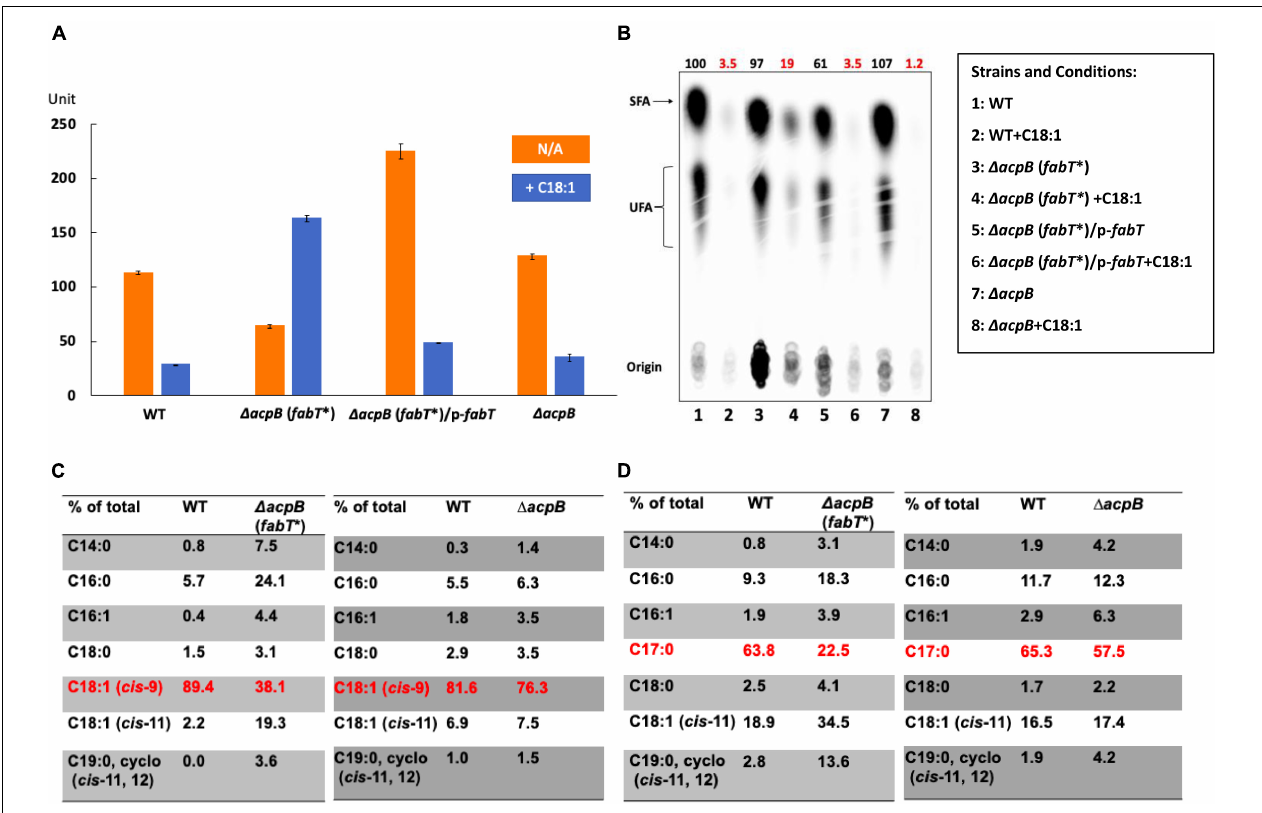
FIGURE 9 | The FabT ∗ mutation in the acpB:cat strain used previously results in a phenotype that differs from that of the newly constructed (cid:49) acpB strain. (A) Comparison between the two (cid:49) acpB strains of exogenous oleic acid supplementation on β -galactosidase production from the fabT promoter. The pfabT denotes a plasmid encoding wild type FabT. (B) Incorporation of [ 14 C] acetate into cell membrane phospholipids of the two (cid:49) acpB strains with additions as given. (C) The differing acyl chain compositions of the cell membrane phospholipids of the two (cid:49) acpB strains grown in the presence of oleic acid Comparison of bacterial de novo fatty acid biosynthesis. (D) The differing acyl chain compositions of the cell membrane phospholipids of the two (cid:49) acpB strains grown in the presence of margaric